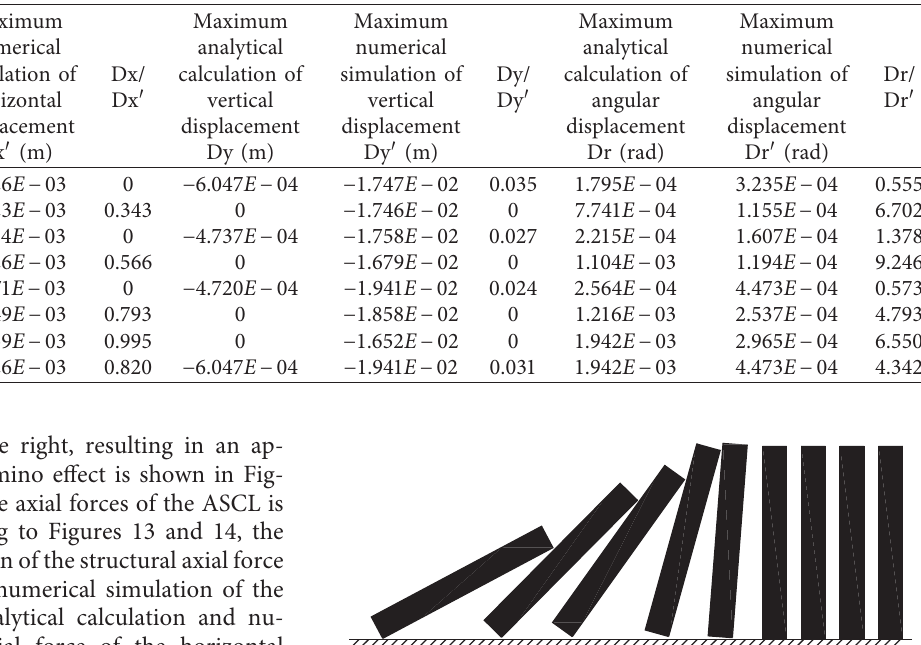
Table 4: A comparative table of the structural displacements of the antislide members.